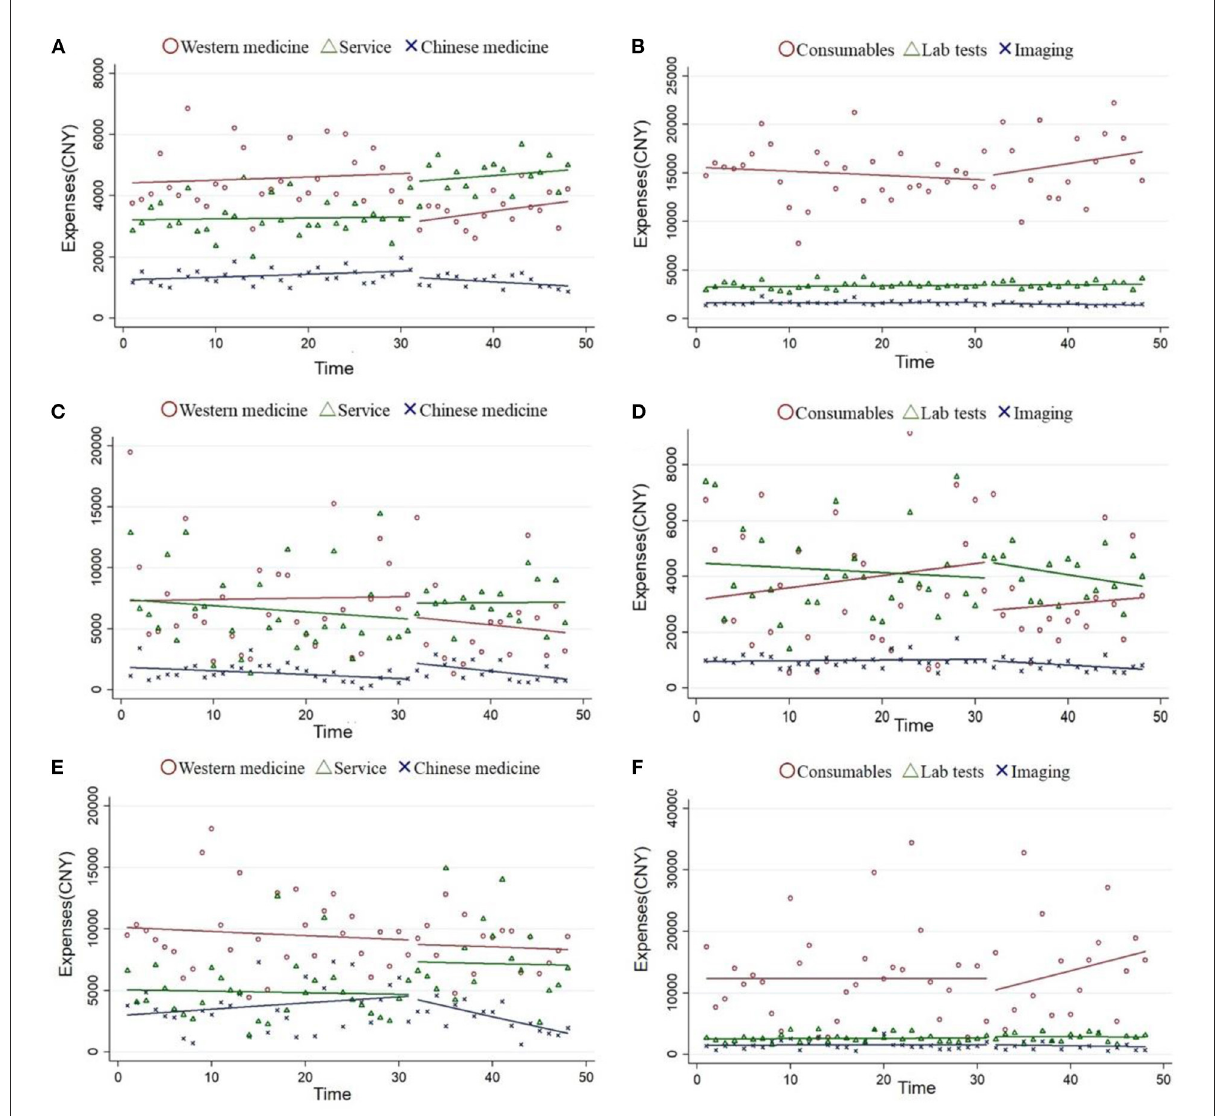
FIGURE1 Changes in disaggregated hospitalization expenses (ITS model). Ischemic heart disease (A,B) ; chronic renal failure (C,D) ; and lung cancer (E,F)